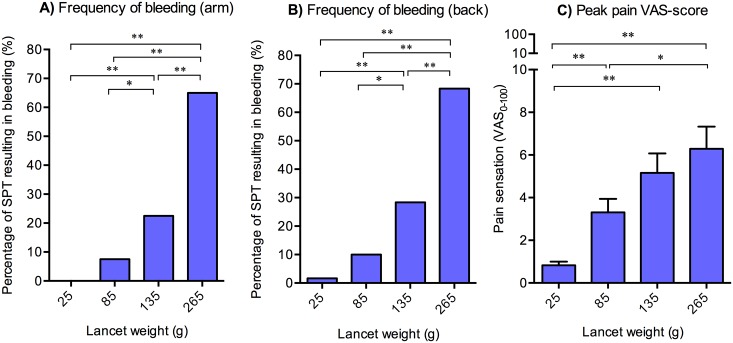
The percentage distribution of bleeding incidents in response to individual SPTs when using the four lancet weights; 25 g, 85 g, 135 g and 265 g at A) the arm and B) the back, regardless of the applied solution (saline, 1 mg/mL histamine or 10 mg/mL histamine). A higher lancet weight caused increased incidents of bleeding. C) Peak pain intensity in response to the four lancet weights for both arm and back rated on a coVAS. The peak pain intensity increased significantly with increased weight. Notice that pain during SPT, regardless of weight, remains negligible, i.e. < 8 on a 0–100 VAS (N.B.: discrete x-axis is applied for graph C). For each condition; n = 20. * = p < 0.05, ** = p < 0.01. C) Mean ± SEM.